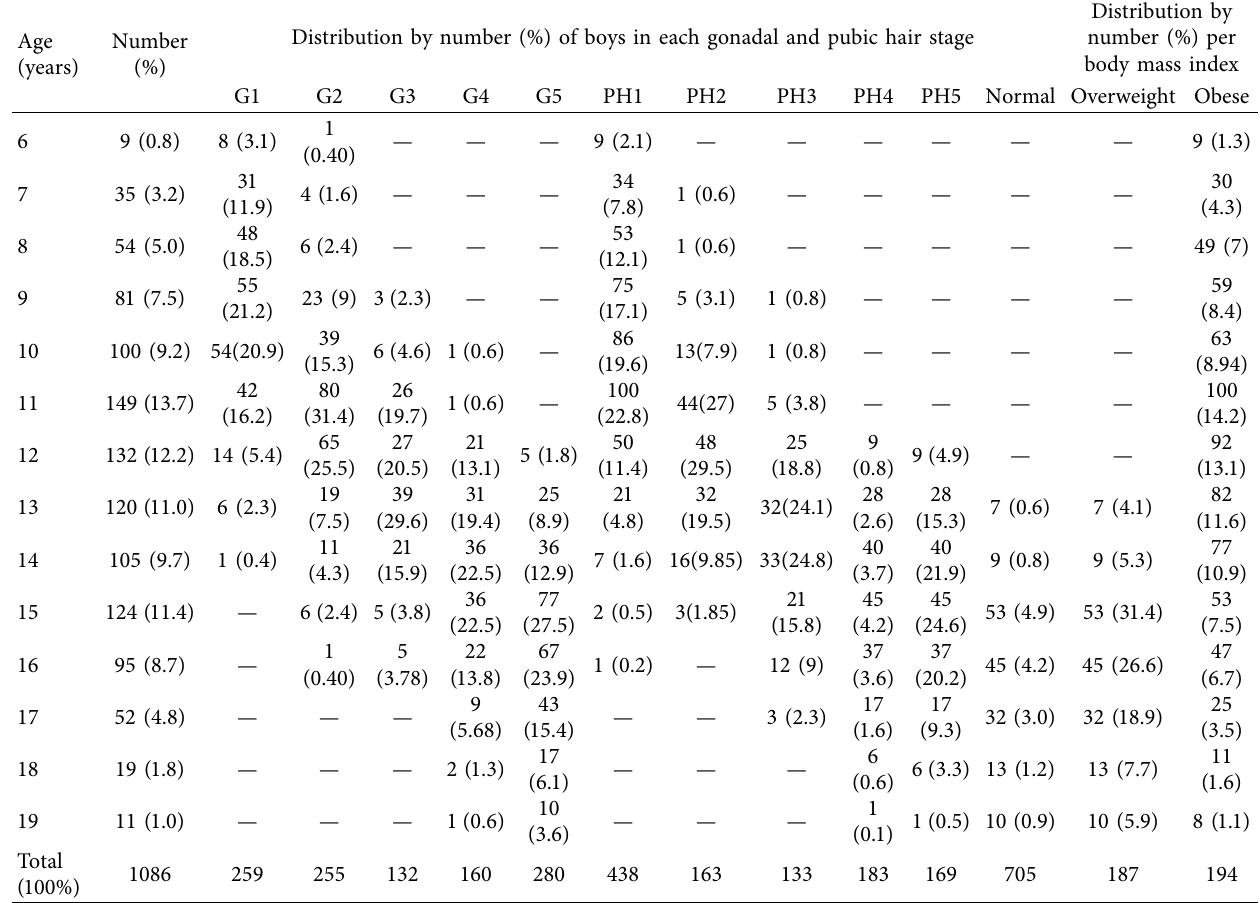
Table 1: Distribution of schoolboys in each age (year) per pubertal staging and per body mass index.